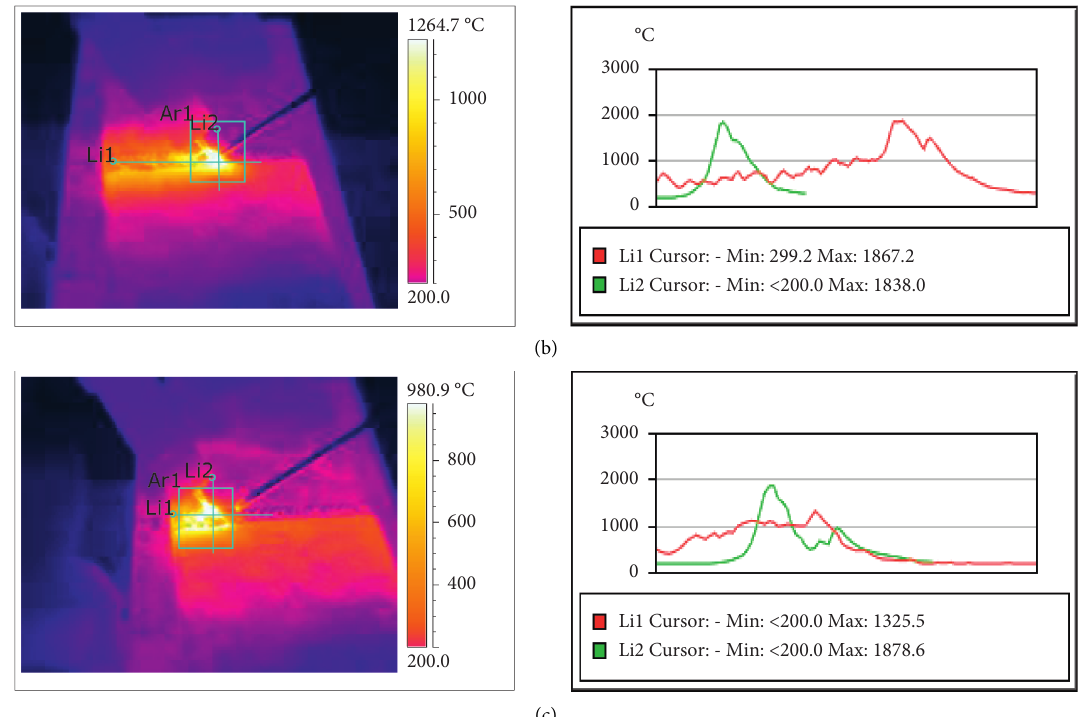
Figure 10: Infrared thermography pass-wise analysis during the process. (a) Pass-1 IN625 to IN625. (b) Pass-2 IN625 to IN625. (c) Pass-3 IN625 to IN625.